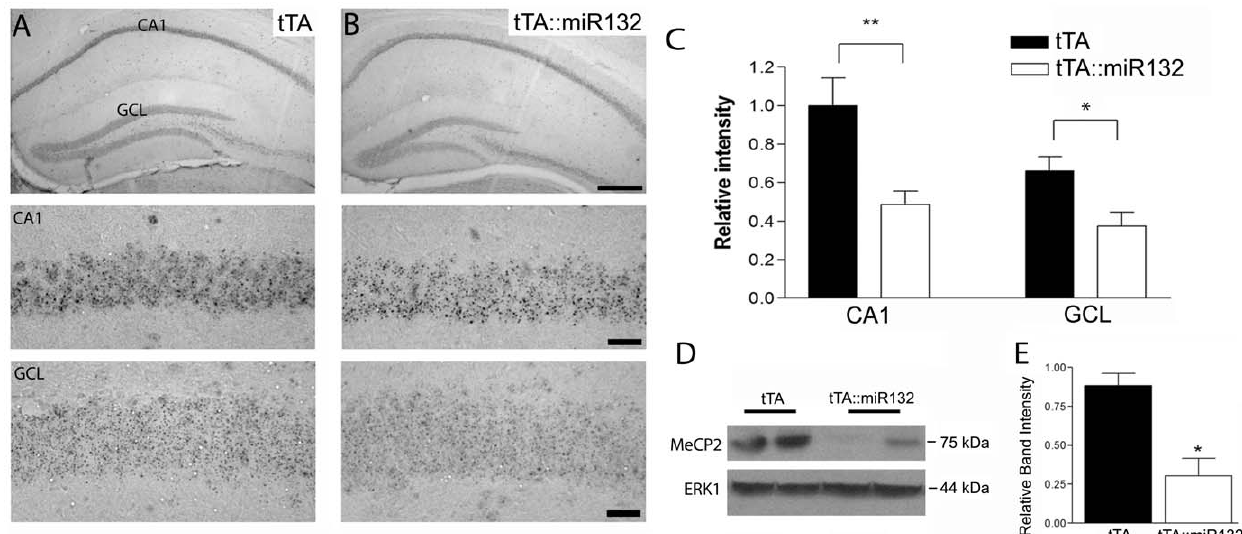
Figure 4. Decreased MeCP2 expression in tTA::miR132 mice. A and B: Top panels) Representative immunohistochemical labeling for MeCP2 in the dorsal hippocampus of tTA monotransgenic (A) and tTA::miR132 bitransgenic (B) mice. Relative to tTA littermates, mice over-expressing miR132 showed a decrease in MeCP2 expression within the excitatory cell layers of the hippocampus. Scale bar: 200 m m. Middle and bottom panels) High magnification images of MeCP2 labeling within area CA1 and the GCL are presented. Scale bar: 100 m m. (C) Quantitative analysis of the mean 6 SEM MeCP2 expression in area CA1 and the GCL. Of note, MeCP2 expression was significantly reduced in tTA::miR132 mice (n=7) compared to monotransgenic controls (n=8) (**P , 0.01, *P , 0.05). (D) Western analysis of biological replicates (two animals per condition) confirming the reduction in MeCP2 expression in tTA::miR132 mice, along with quantitative densitometric analysis relative to endogenous ERK1 levels (E), presented as mean 6 SEM (n=3) (*P , 0.05).